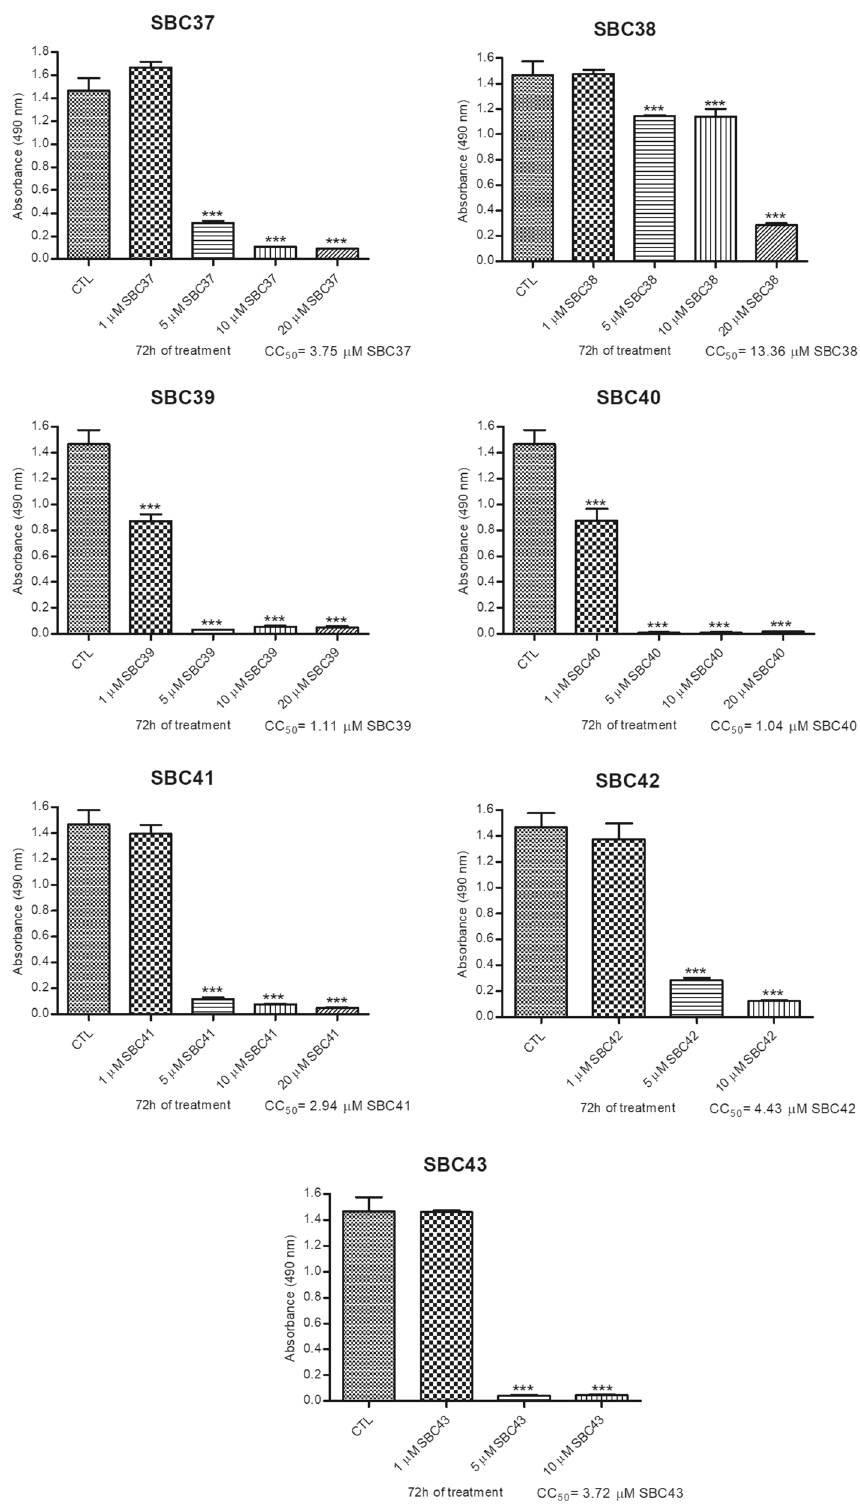
Figure 2. Evaluation of cytotoxicity effects of SBCs on Leishmania amazonensis promastigotes. Cell viability and cytotoxicity were evaluated against promastigotes using the MTS/PMS assay after 72 h of treatment. The cytotoxicity concentration to reduce 50% of viable promastigotes (CC 50 ) was determined. SBC37, SBC39, SBC40, SBC41, SBC42, and SBC43 presented CC 50 lower than 5 µM. Bars represent standard deviation; * p < 0.05, ** p < 0.01, and *** p <